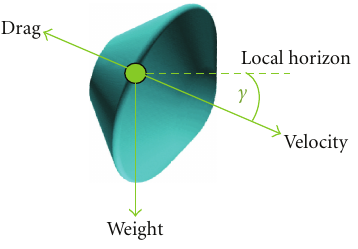
Figure 3: Aerodynamic forces acting on the atmospheric vehicle.